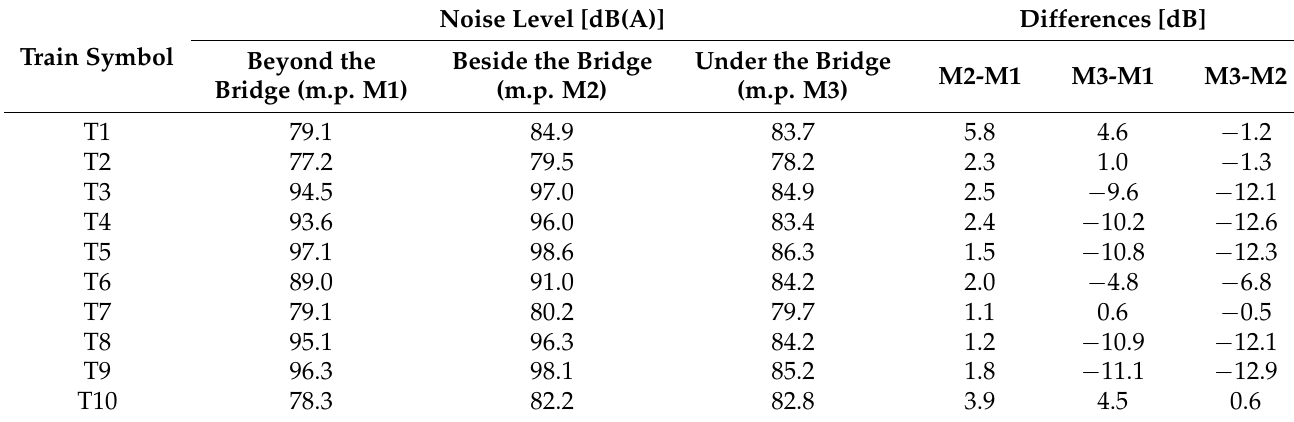
Table 2. Results of noise measurements.